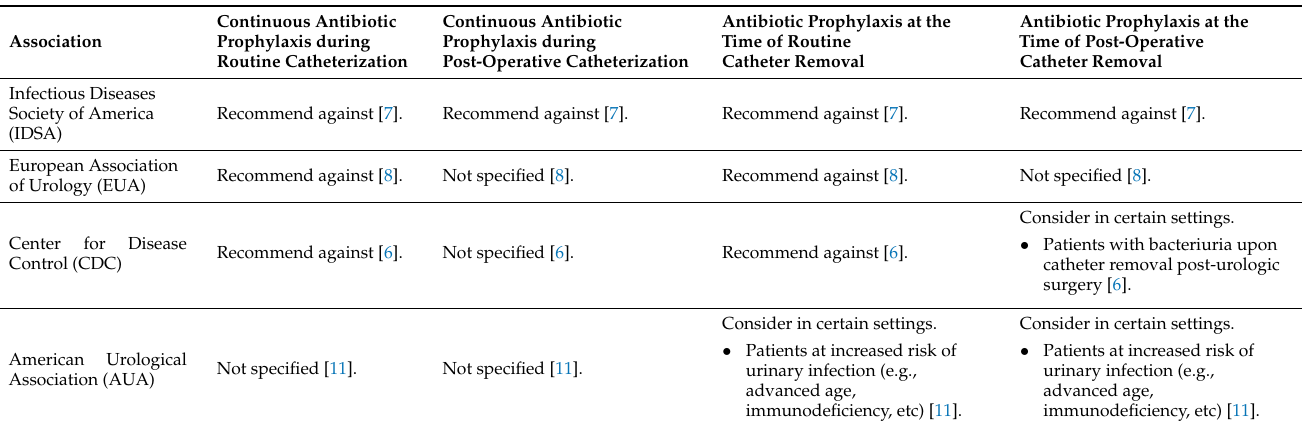
Table 2. Summary of guideline recommendations regarding the use of continuous or peri-removal antibiotic prophylaxis with indwelling urinary